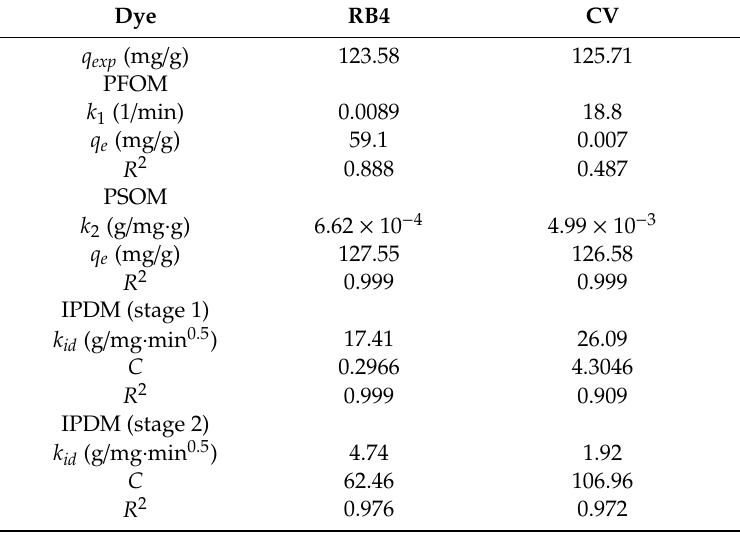
Table 3. Kinetic parameters for the adsorption of dyes onto rice bran / SnO 2 / Fe 3 O 4 at 50 ◦ C. Dye RB4